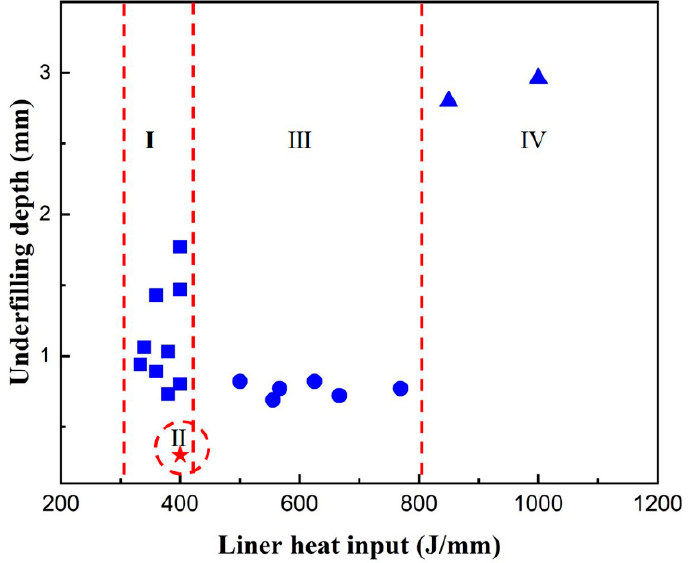
Figure 5. The scatter diagram of Du as a function of linear heat input.